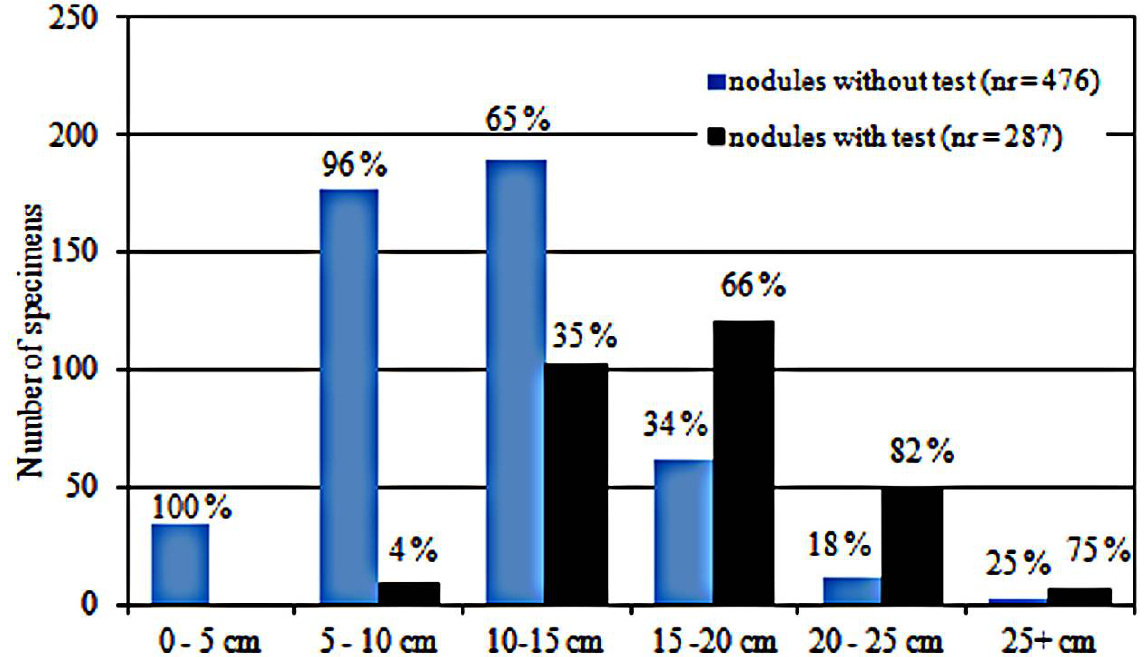
Figure 15. Presence and absence of raw material testing on nodules abandoned in ST20 shaft of Petit-Spiennes. Graph M. Woodbury,